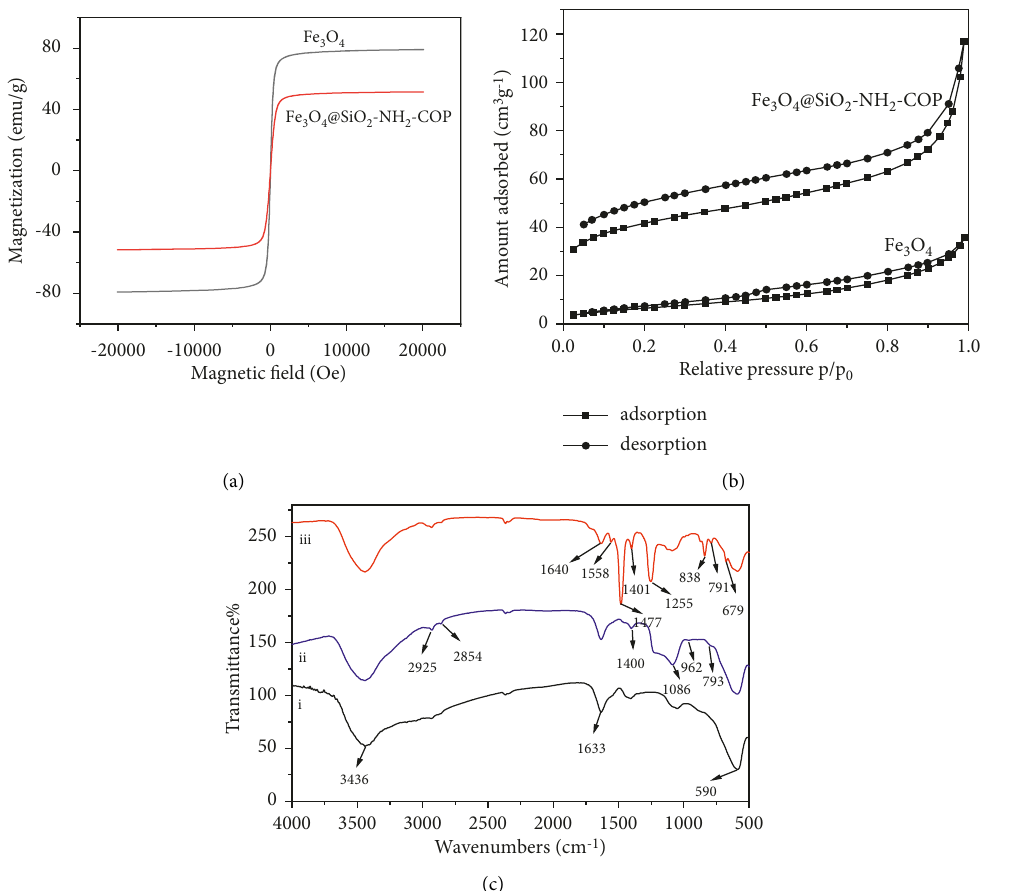
Figure 5: (a) Magnetization curves of Fe 3 O 4 and Fe 3 O 4 @SiO 2 -NH 2 -COP. (b) N 2 adsorption-desorption isotherms of Fe 3 O 4 and Fe 3 O 4 @ SiO 2 -NH 2 -COP. (c) FT-IR spectra of (i) Fe 3 O 4 , (ii) Fe 3 O 4 @SiO 2 -NH 2 , and (iii) Fe 3 O 4 @SiO 2 -NH 2